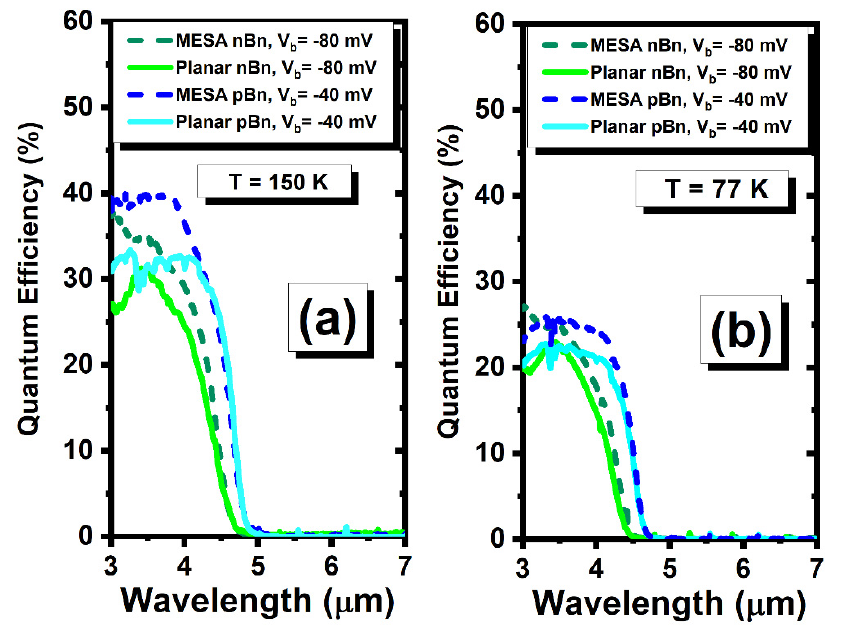
Figure 5. Saturated 77 ( a ) and 150 K ( b ) QE spectra measured for planar and mesa-etched MWIR SLS photodetectors (diode with 200 µm diameter). Table 2. Comparison of the QE values at peak responsivity for planar and mesa-isolated SLS devices at 77 and 150 K. (V b = − 40 mV for pBn and V b = − 80 mV for nBn